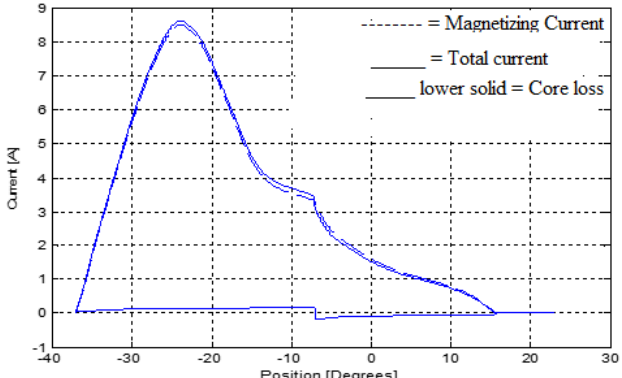
Fig. 10. Representation of current waveforms at conduction angle of 31 0